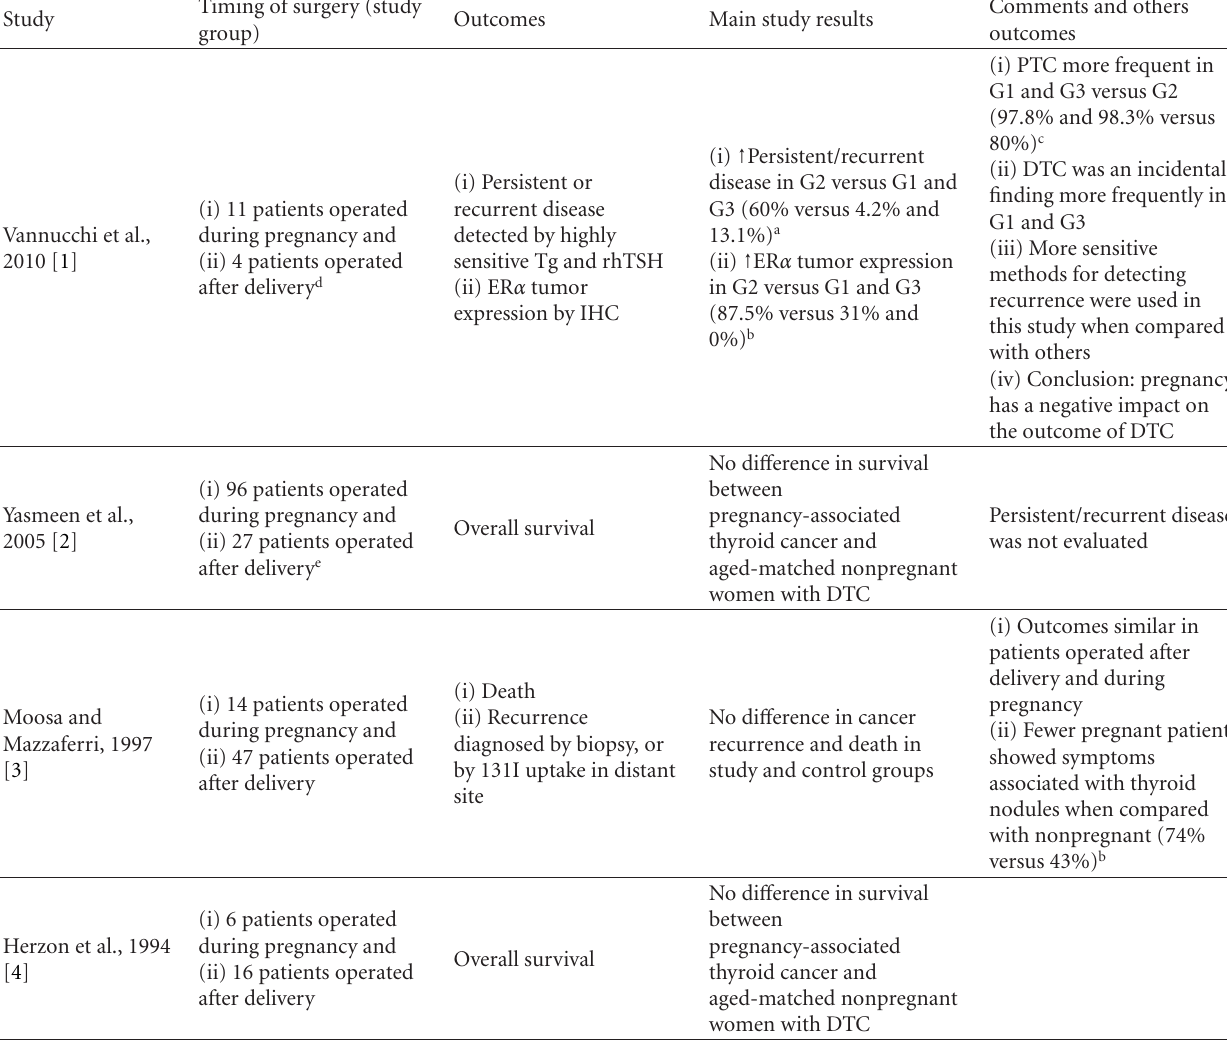
Table 2: Main outcomes in patients with di ff erentiated thyroid cancer (DTC) diagnosed during pregnancy or within 12 months of childbirth.